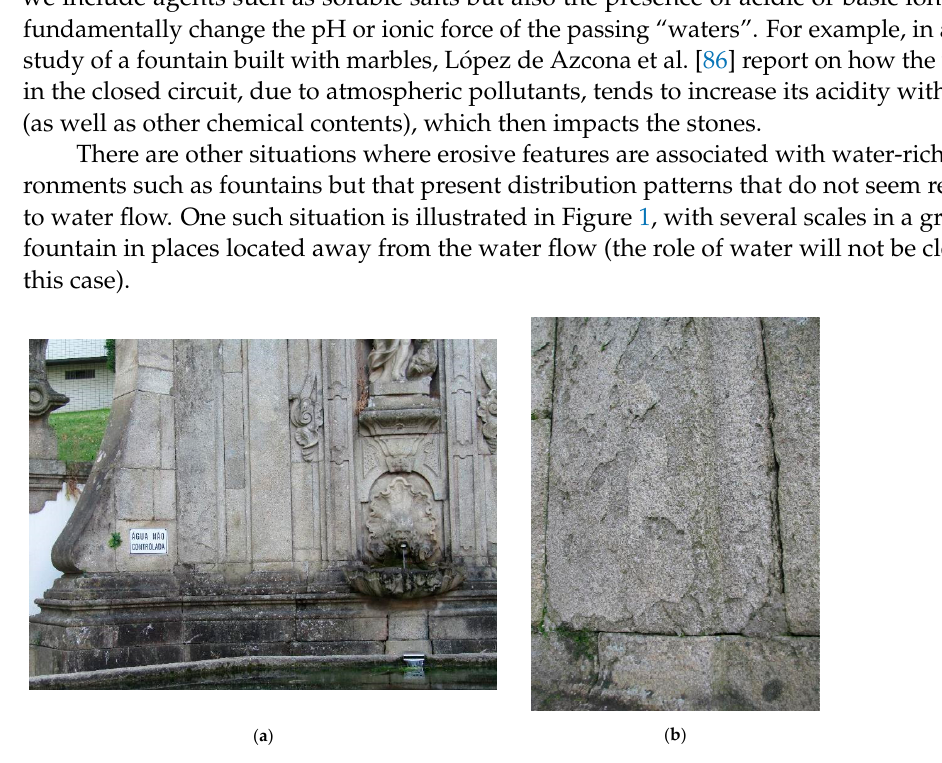
Figure 1. Example of erosive features on granite stones in a water fountain of Braga (NW Portugal): ( a ) general view showing the position of the eroded portions in relation to the water flow (to the left, near the warning in Portuguese—“ÁGUA NÃO CONTROLADA”); ( b ) detail of the erosive features.